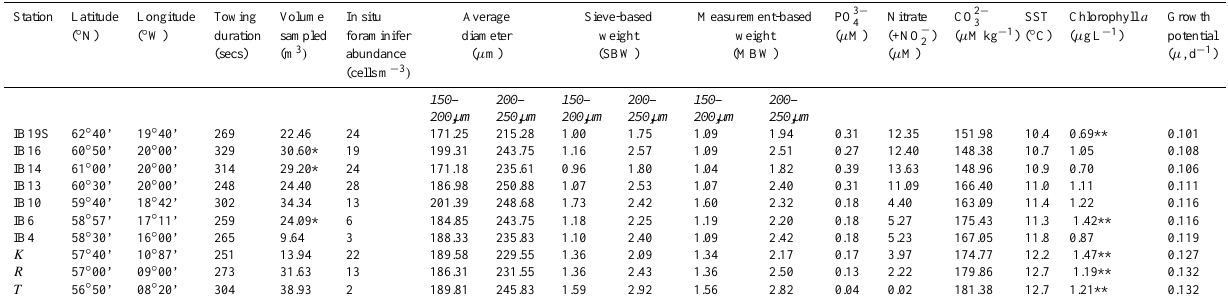
Table 2. Data obtained for each sample station during the D340a Extended Ellett Line cruise: ∗ denotes sampled volumes where a correction factor was used (original values were: IB16 – 1.47, IB14 – no data; IB6 – 3.70); ∗∗ denotes chlorophyll a values that were obtained from the surface underway fluorometer rather than from discrete CTD Niskin bottle